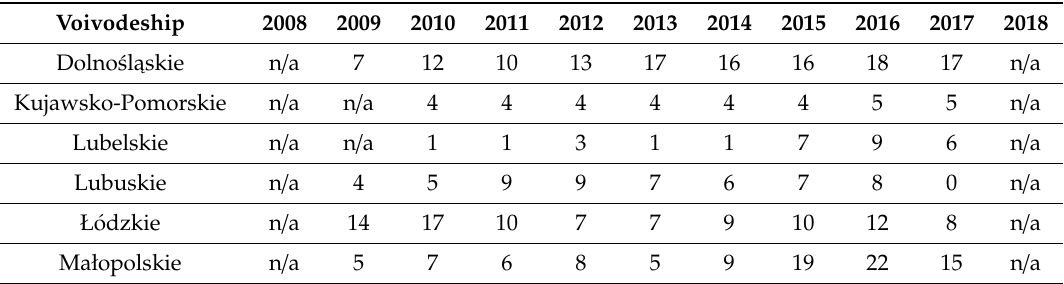
Figure 8. Distribution of drug program services according to the patients’ age and gender in 2017. Table 4. Number of drug packages released to E84 patients during a year as part of the program “Treatment of Chronic Lung Infections in Patient with Cystic Fibrosis”